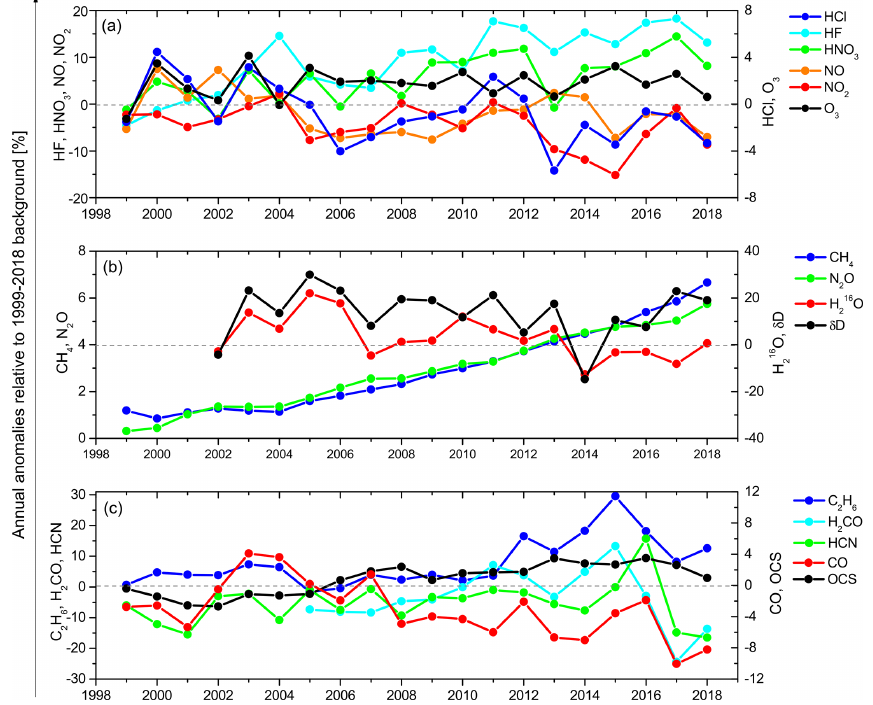
Figure 8. Time series of annual anomalies relative to the 1999–2018 background (in %) for NDACC TCs of (a) stratospheric gases (HCl, HF, HNO 3 , NO, NO 3 , and O 3 ), (b) greenhouse gases (CH 4 , H 2 O, and N 2 O) and δ D, and (c) tropospheric and air quality gases (C 2 H 6 , CO, HC 2 O, HCN, and OCS). Annual anomalies are computed according to temporal decomposition as detailed in Appendix